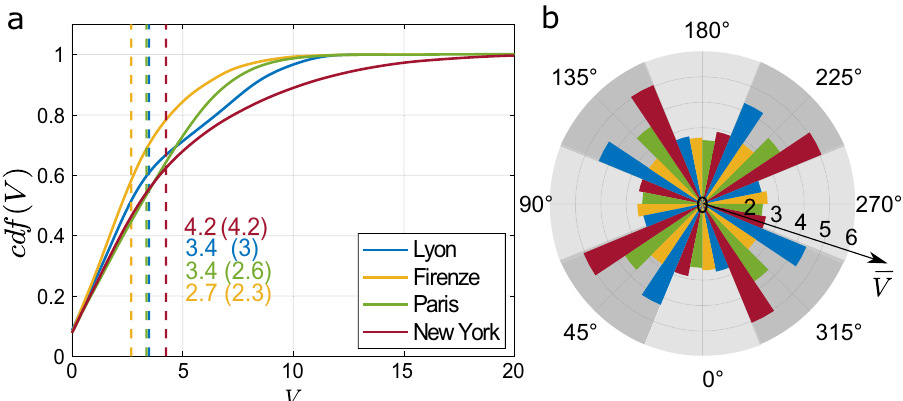
Figure 2. Vulnerability distribution for different cities and wind directions. (a) Cdf of node vulnerability for the different cities under eight different wind directions. The mean vulnerability is shown as a dashed line and reported numerically together with the standard deviation (in parentheses). (b) Mean vulnerability of city networks for each wind direction. Colors blue, yellow, green and magenta correspond to the urban networks of Lyon, Firenze, Paris and New York,